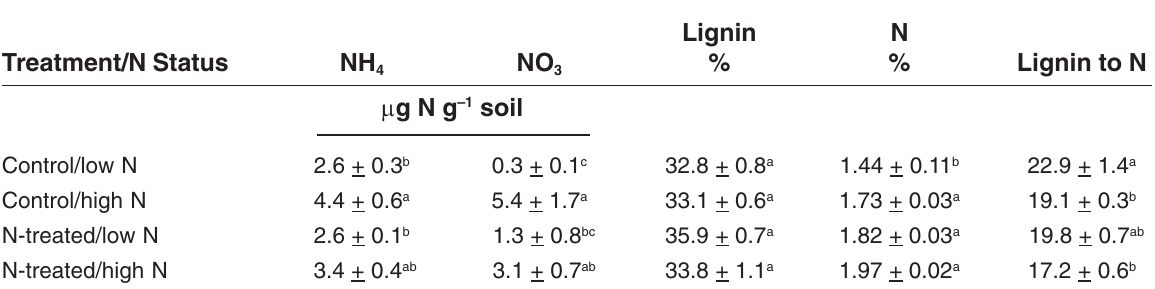
Means (+1 SE) for Extractable NH and NO Pools, Litter Lignin and N Concentrations, 4 3 and Lignin to N Ratios for Low N Processing and High N Processing Plots Within Control and N-Treated Watersheds of Fernow Experimental Forest, West